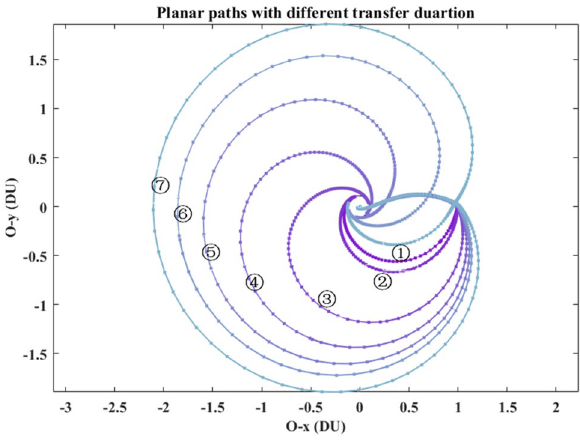
Figure 9. The planar paths in the overall view.